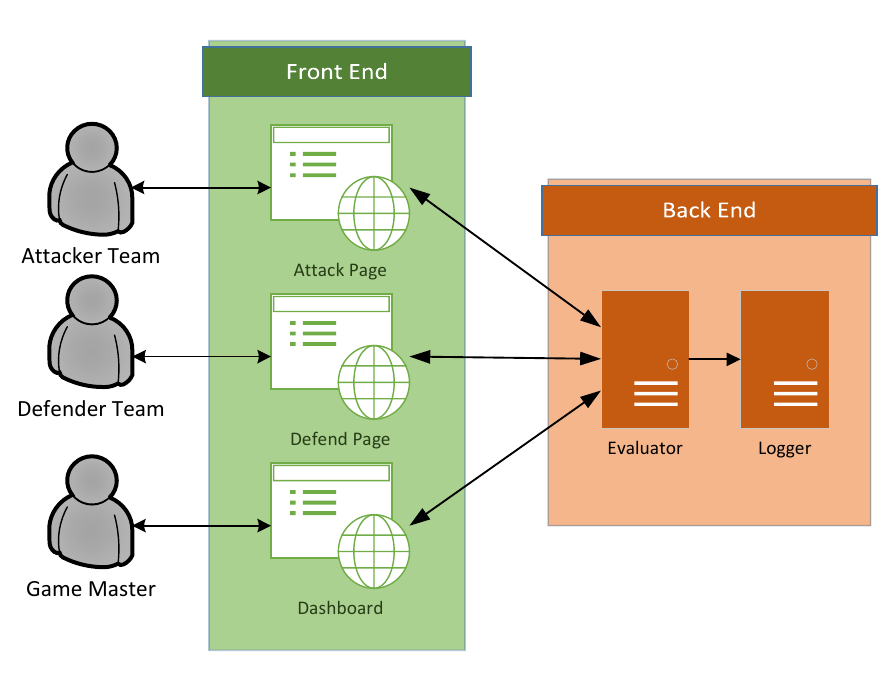
Figure 4. Digital